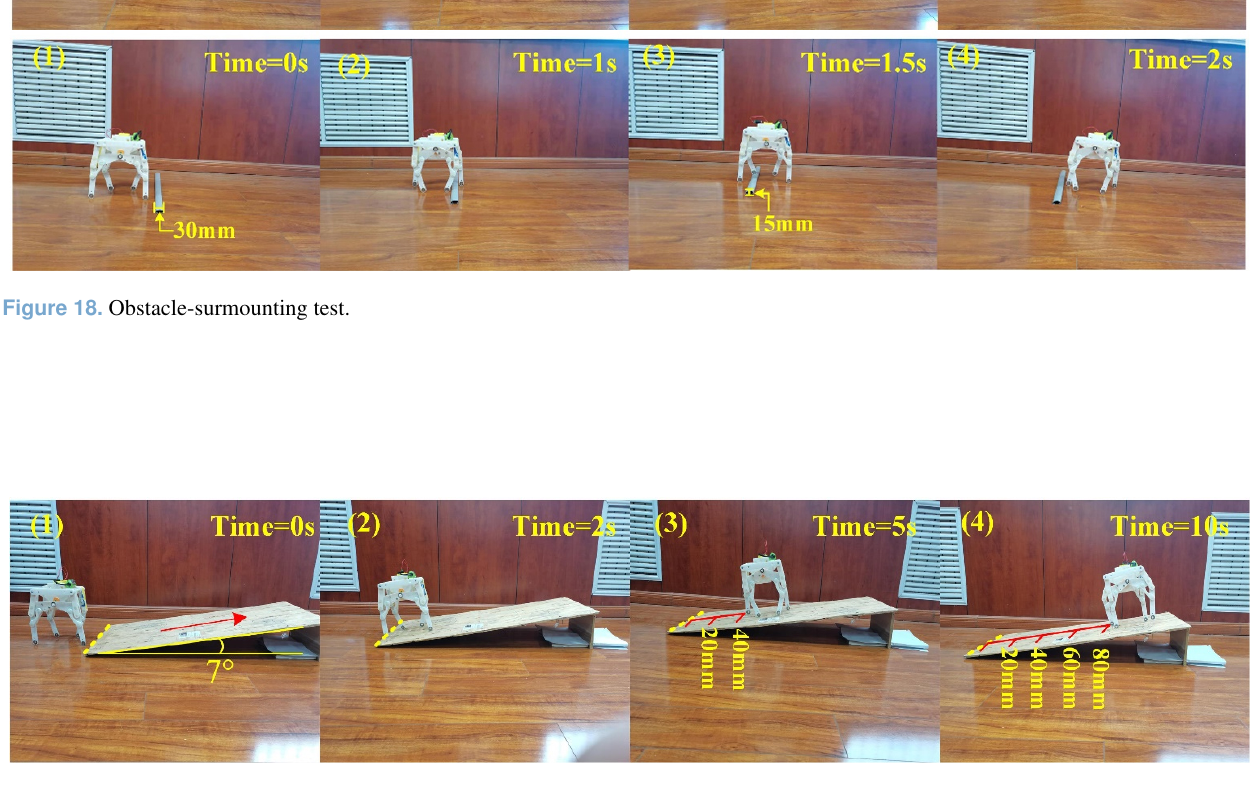
Figure 19. Climbing